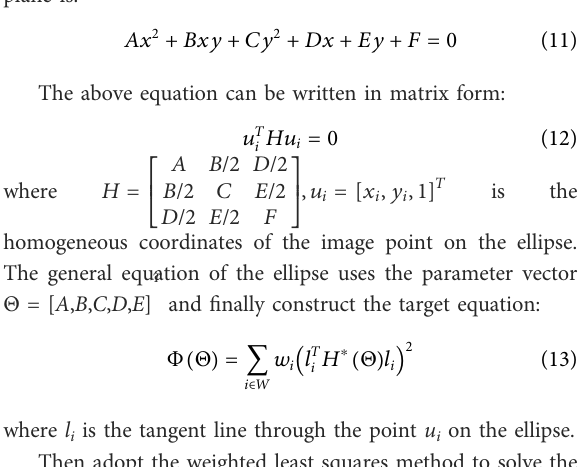
image coordinate system in pixels and in the right image coordinate system in pixels. From any point on the image surface of the left camera, as long as the corresponding matching point can be found on the image plane of the right camera (the two points are the same point in space on the left and right camera images), the 3D coordinate value of the point can be determined.